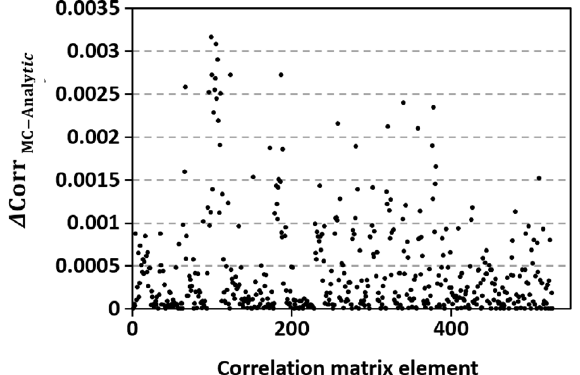
Fig. 5. The absolute difference in the correlation matrix between the two analyses at step (3).